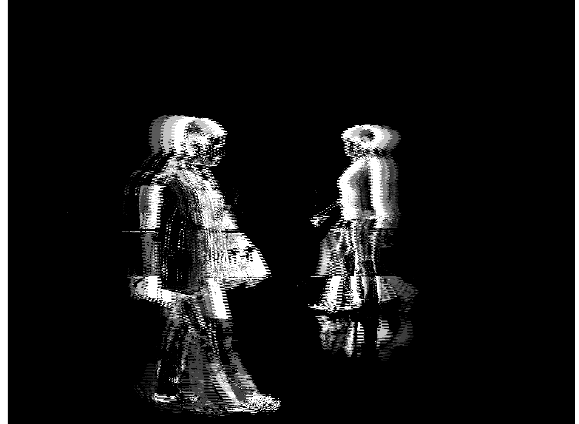
Figure 10. Total charge for N th = 45 B